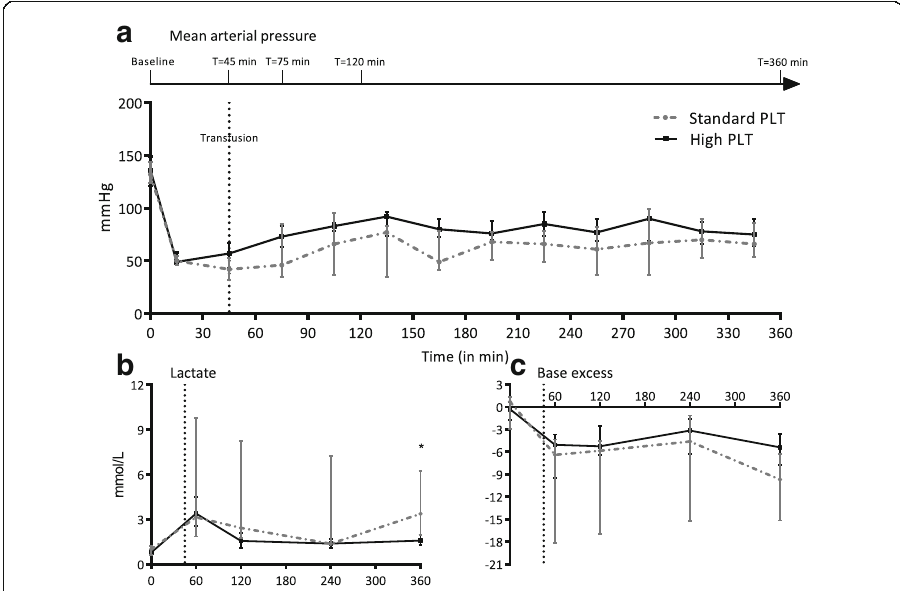
Fig. 1 Shock parameters. Data are presented as median (IQR). a Mean arterial pressure. Line with arrow represents specific time points of coagulation status assessment during the experiment. Baseline (=before trauma), T = 45 min (=just before initiation of resuscitation), T = 75, T = 120, and T = 360 min (after injury). b Lactate. c Base excess. PLT platelet transfusion, MAP mean arterial pressure. Dotted vertical line at 45 min represents initiation of resuscitation. * p < 0.050 between